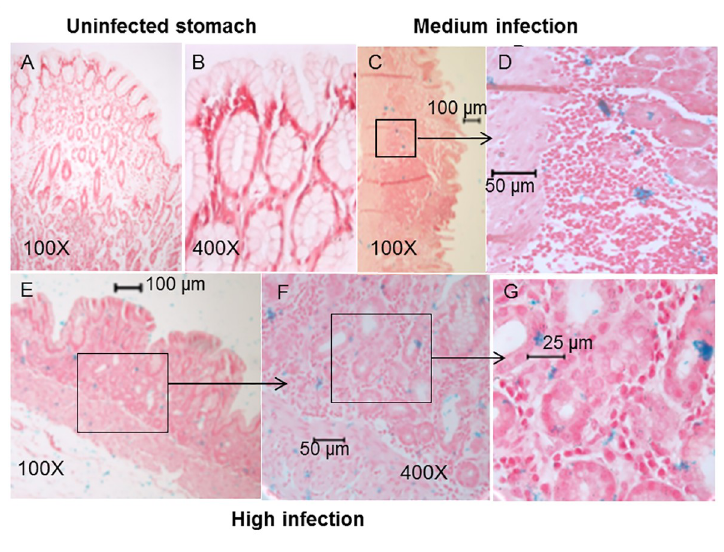
Fig 2. Detection of H . pylori in gastric tissue. In situ hybridization using the H . pylori- specific 16S rRNA probe (blue staining) demonstrates absence and presence of H . pylori in gastric sections. Sections were counterstained with Nuclear Fast Red. A, B) Stomach from an uninfected animal (no blue staining). C, D) Stomach showing a medium infection density. E, F) Stomach showing a high density of H . pylori